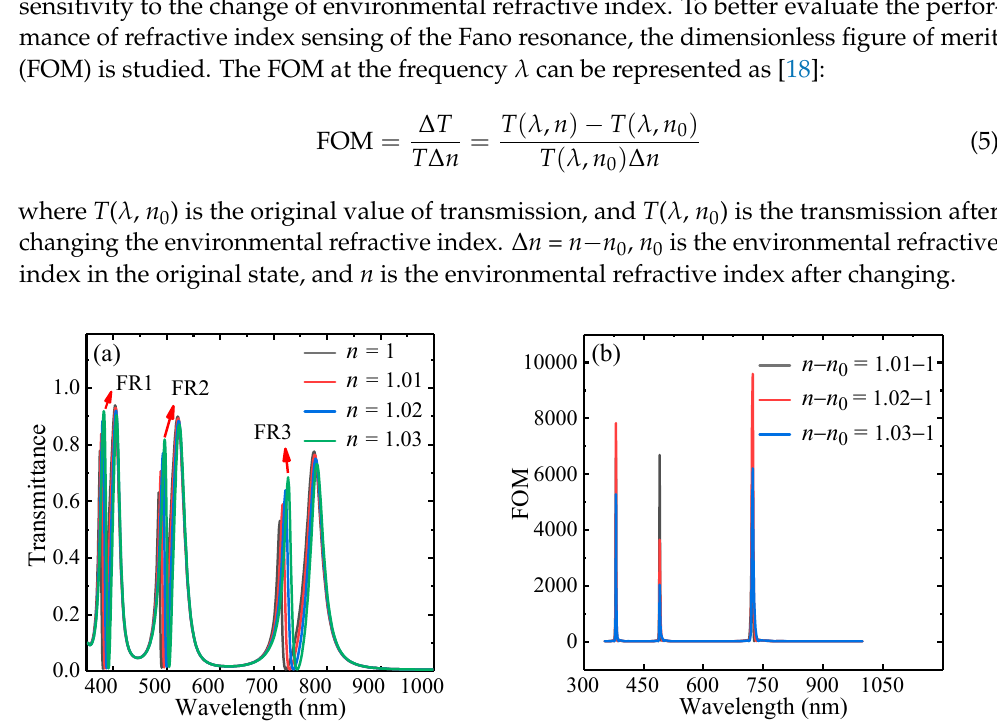
Figure 7. ( a ) Transmission spectrums with n from 1 to 1.03. ( b ) Figure of merit (FOM) of FR1, FR2, and FR3 with different n .